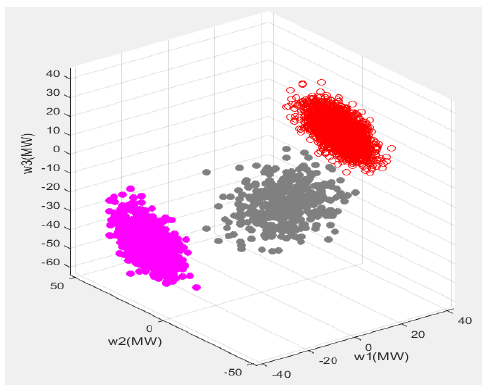
Figure 7. Scatter plot of forecast error data.